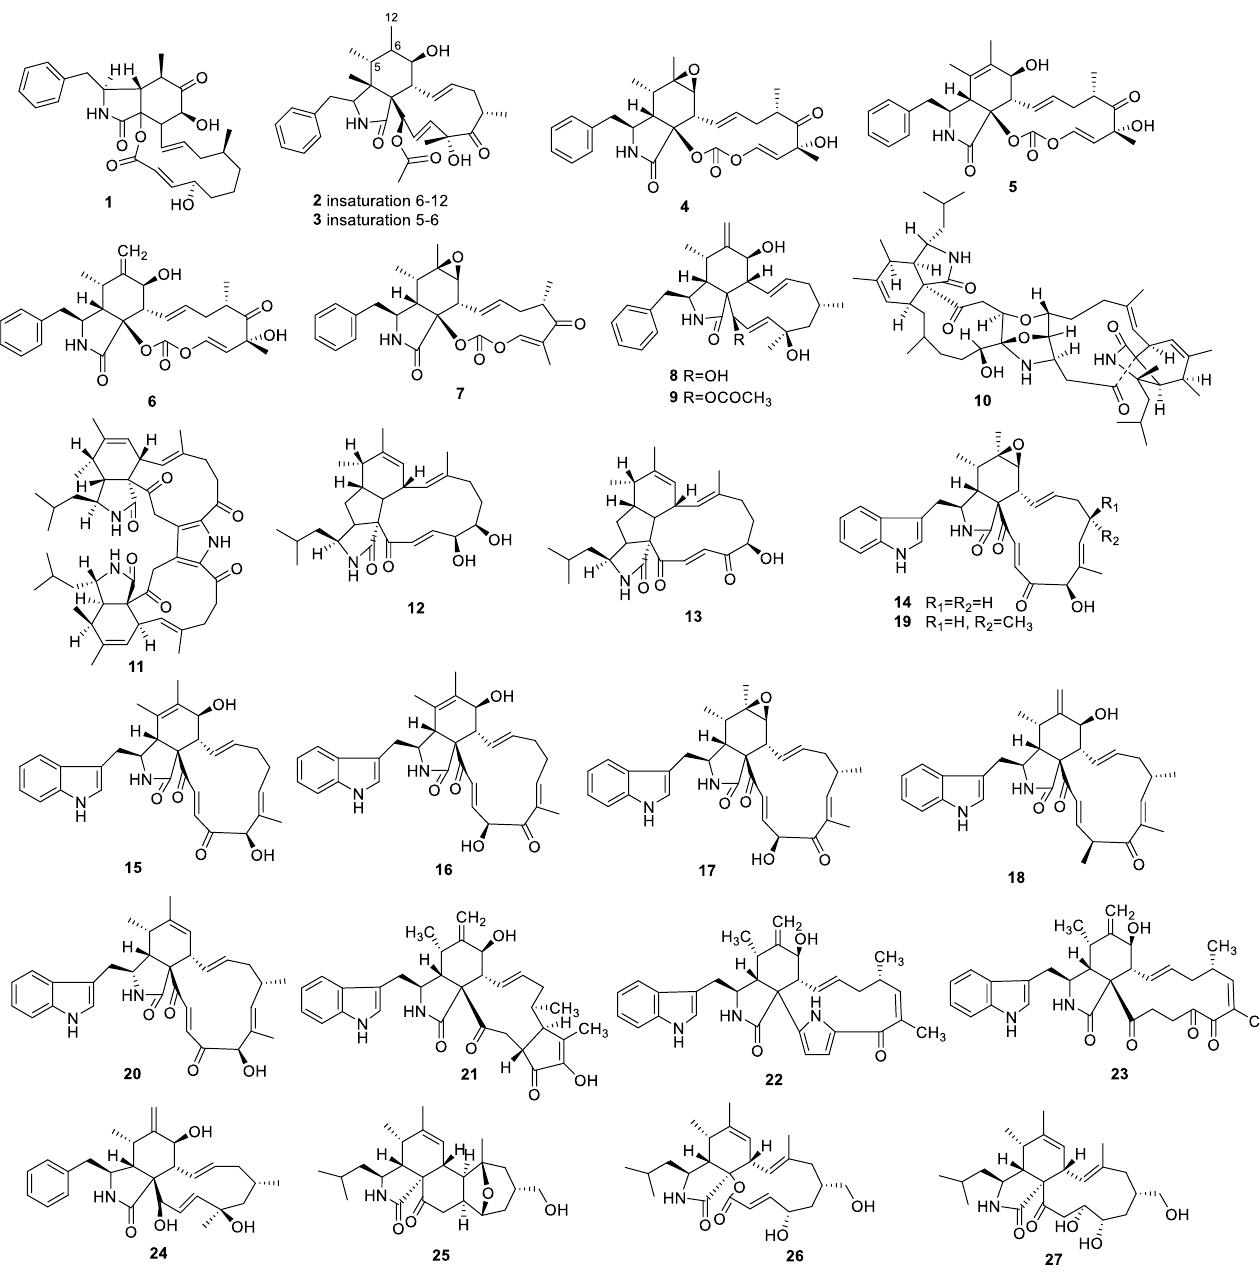
Figure 1. Chemical structures of cytochalasans ( 1 – 27